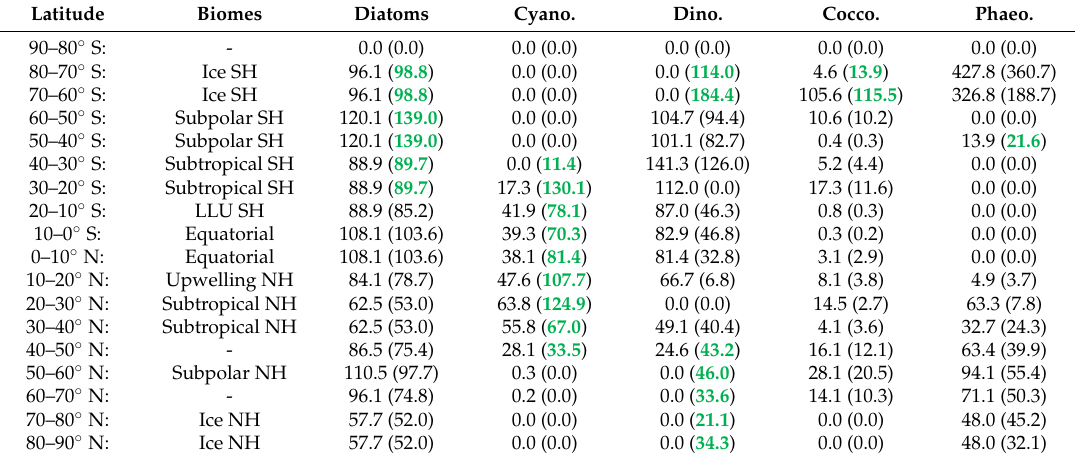
Table 2. For each latitude and functional group, we show the normalized annual mean chlorophyll concentration of phytoplankton at present and end of century (in parenthesis). Functional groups ( µ g Chl. m − 3 ) presented in order: diatoms, cyanobacteria, dinoflagellates et al., coccolithophores, and Phaeocystis . For efficiency of comprehension, latitudes which have experienced growth have been bolded in green. Ecological biomes are in order of: Southern Hemisphere sea ice, Southern Hemisphere subpolar, Southern Hemisphere subtropical, Southern Hemisphere low-latitude upwelling, Equatorial, Northern Hemisphere low-latitude upwelling, Northern Hemisphere subtropical, Northern Hemisphere subpolar, Northern Hemisphere sea